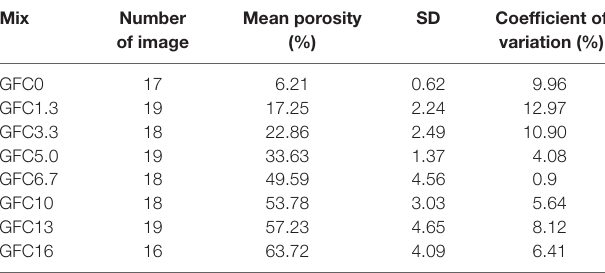
Table 2 | Porosity measured by the ia method and the sD and coefficient of variation.